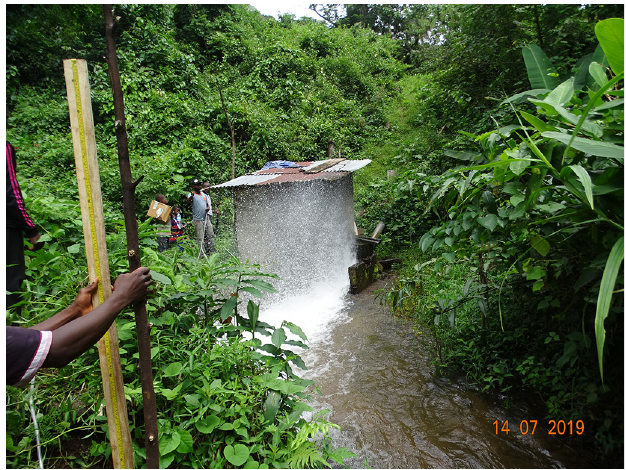
Fig. 4. Forebay with wrong pipe type and mud in Bapi- Cameroon (PhotoJ. Kenfack).